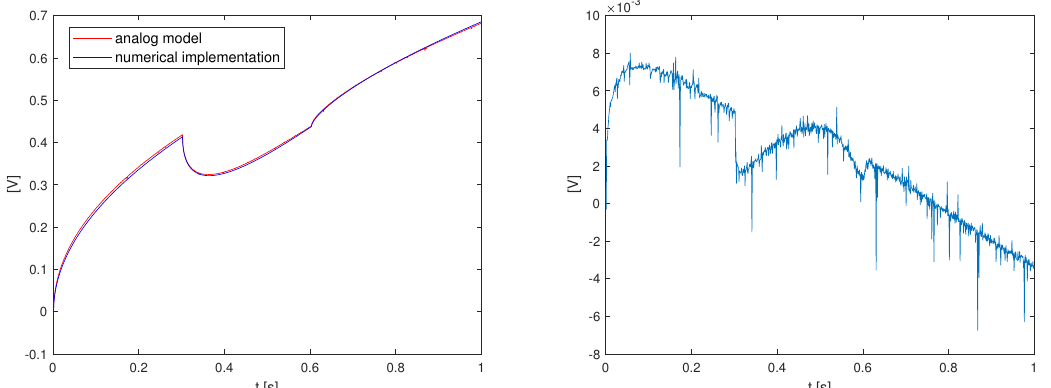
Figure 4. Comparison between experimental data and its numerical implementation based on duality property ( left ); discrepancy between experimental and numerical data ( right